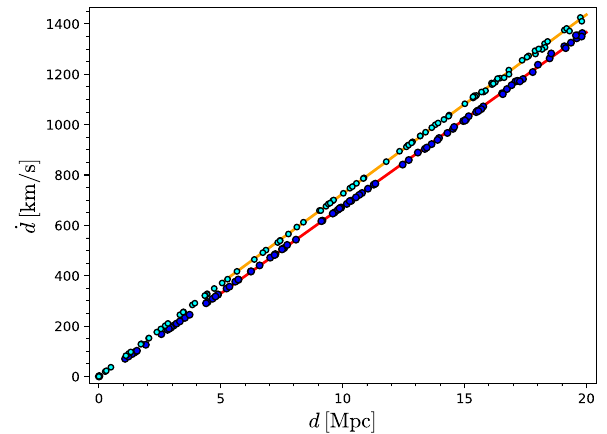
Fig. 11 The Hubble diagram generated for the observer located at the overdensity – blue points and for the observer at the underdensity – light-blue points. The red and orange lines are the respective linear fits to the generated